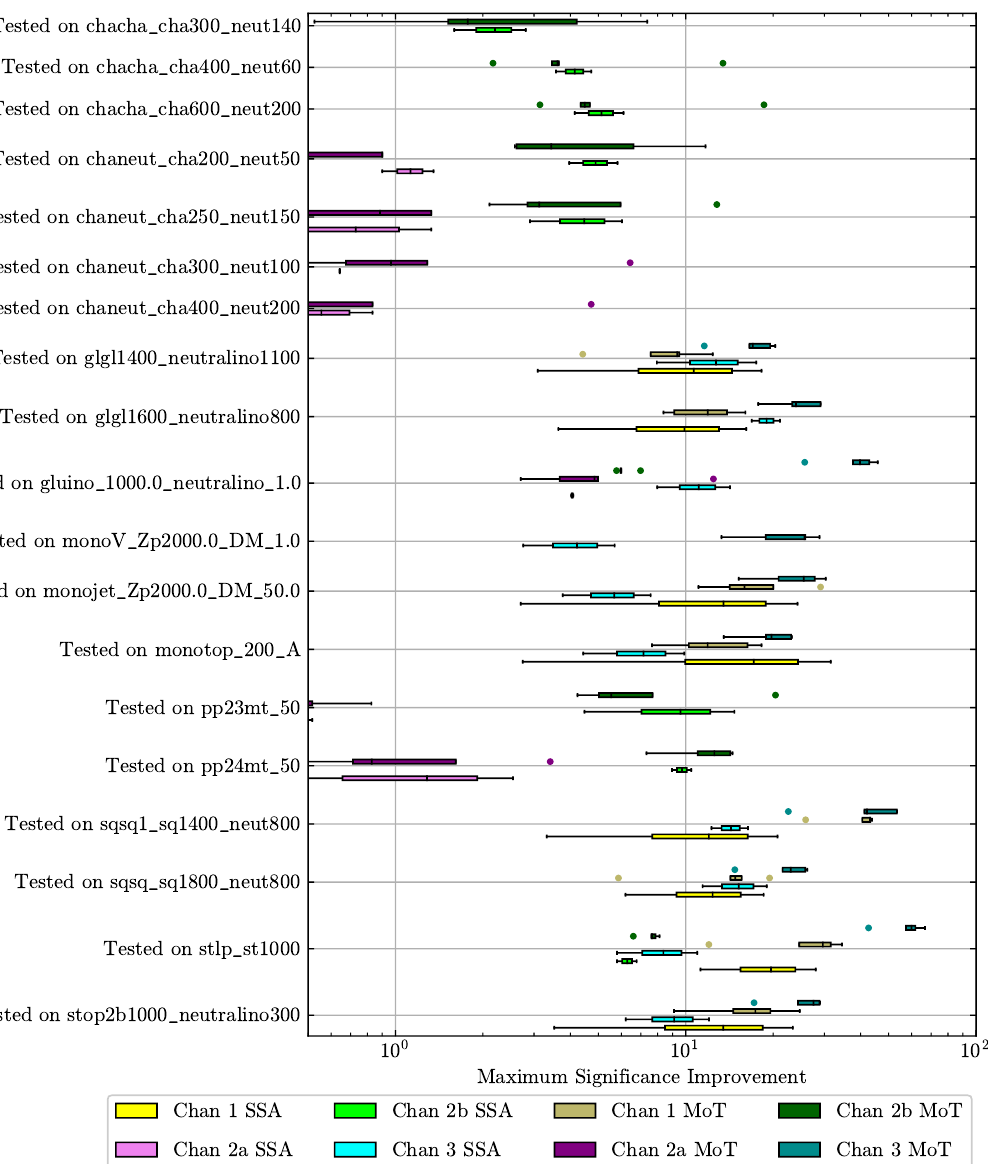
Figure 2 . The figure shows the results for the maximum significance improvements tested with signals from the hackathon data . This compares the supervised methods trained with a mixture of theories (boxes above the middle lines) with those trained with a single signal approach (boxes below the middle lines). Chan X SSA means the results for channel X from the single signal approach. Chan X MoT means the results for channel X from a mixture of theories. SSA contains 2 ML models corresponding to the endpoints of the solid lines in figures 1, 5, 6 and 7, while MoT contains 5 ML models corresponding to the points on the dashed lines that have the same event number as the endpoints of the solid